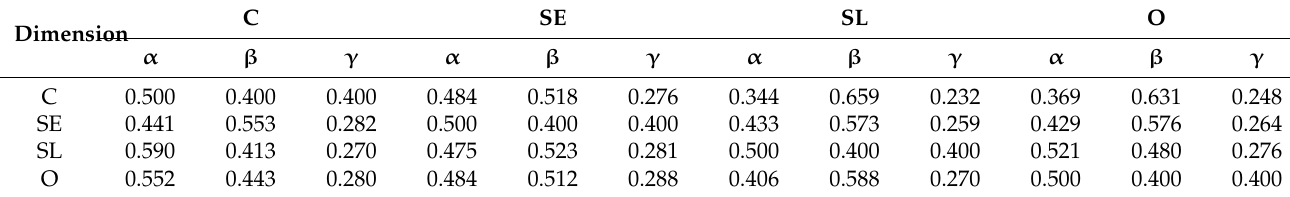
Table 10. The integrated spherical fuzzy comparison matrix.